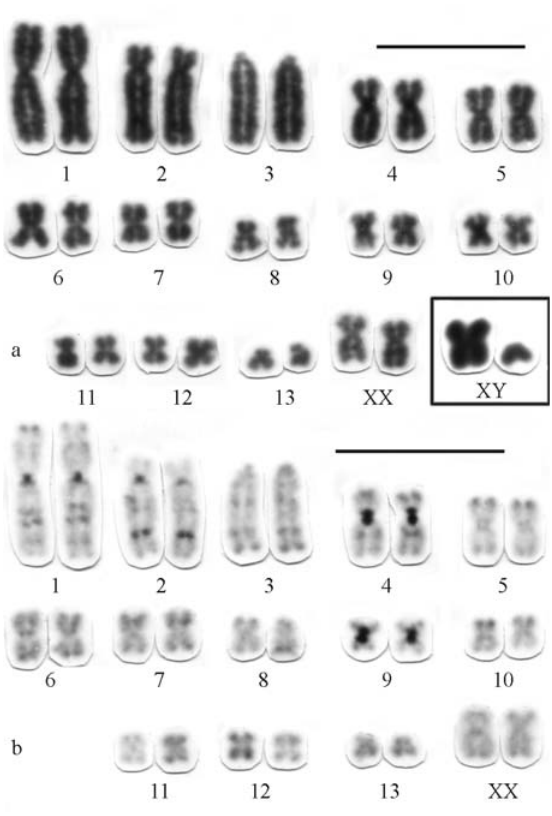
Figure 4 - Karyomorph B with 2n = 28, FN = 50 of P. longicaudatus from Apiacás(MT):a)Karyotypeconventionallystained;b)C-bandingpattern. Bar = 10 (cid:1)